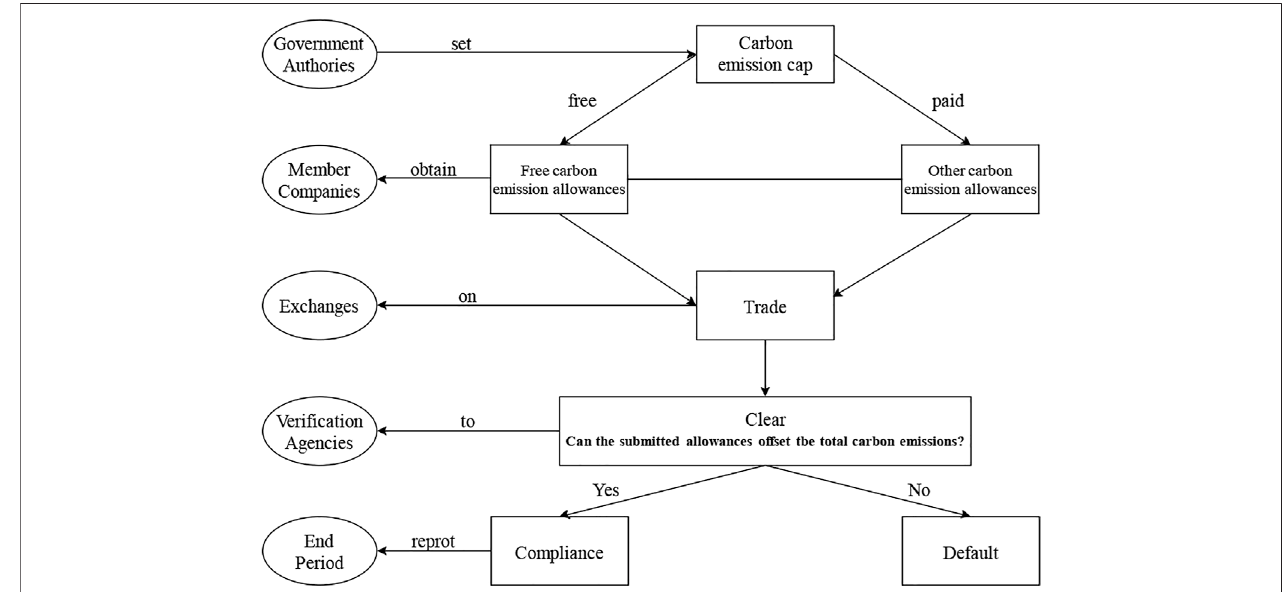
FIGURE 3 | The carbon ETS compliance